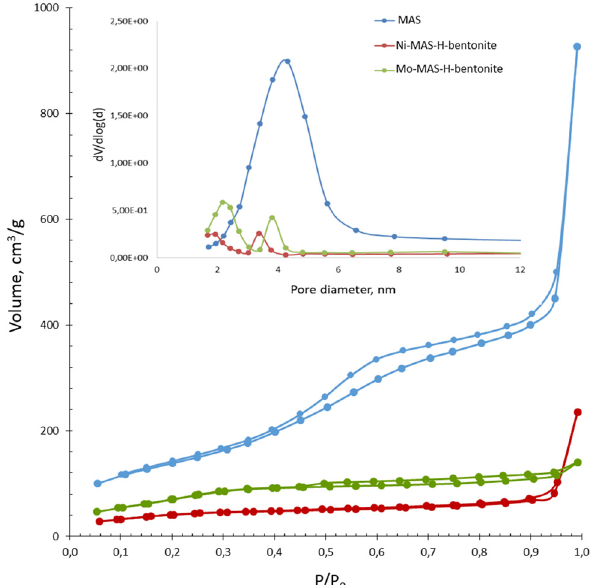
Figure 6: Nitrogen adsorption/desorption isotherms of support material ( MAS ) and Ni, Mo impregnated catalysts.